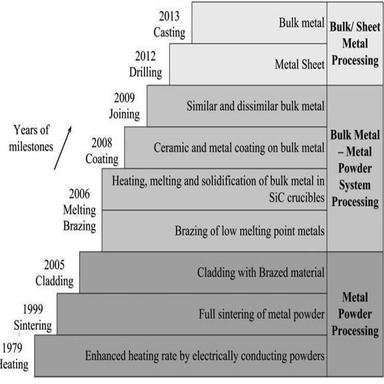
Developed microwave processing techniques for metal-based materials.